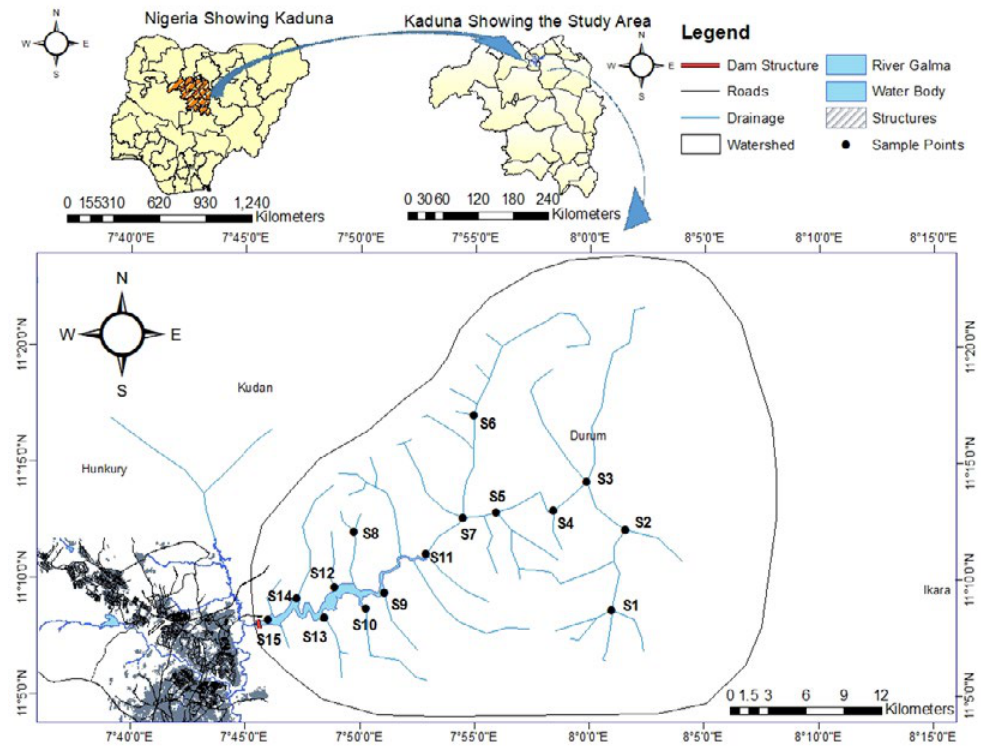
Fig. 1: Geographic location of the study area along with the sampling points in Galma River, Nigeria